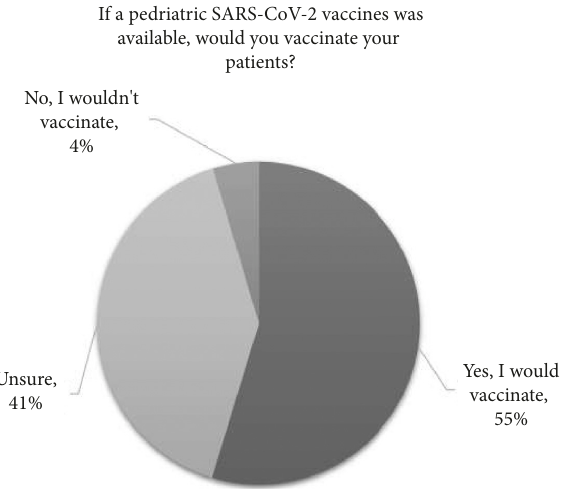
Figure 4: The acceptance rate of future SARS-CoV-2 pediatric Table 2: Correct responses on 10 clinical conditions or contraindications to administering the hexavalent vaccine. Your patient is scheduled to receive the second dose of hexavalent vaccines. Which of the following conditions do you consider contraindicated?